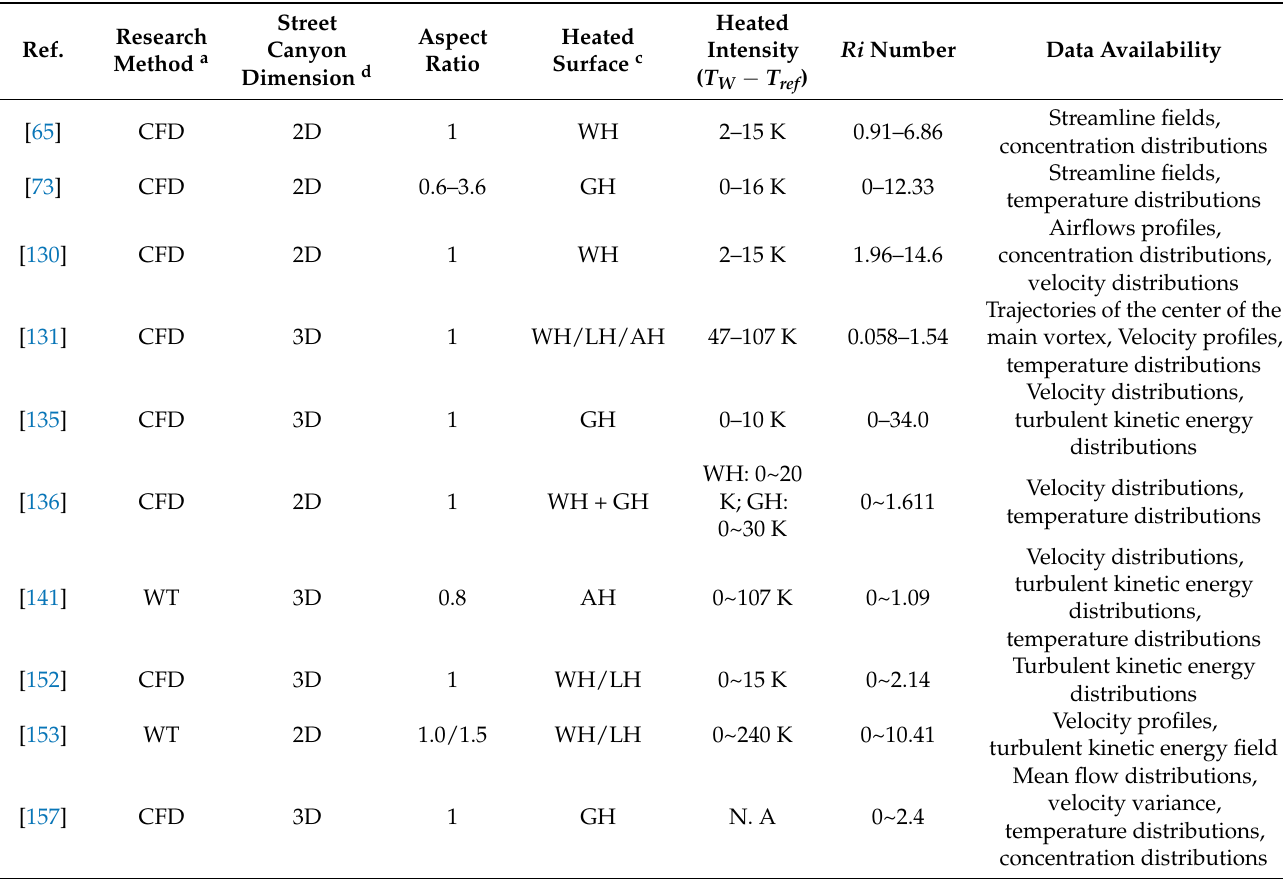
Table 4. Studies on thermal intensity under non-isothermal conditions in street canyons.